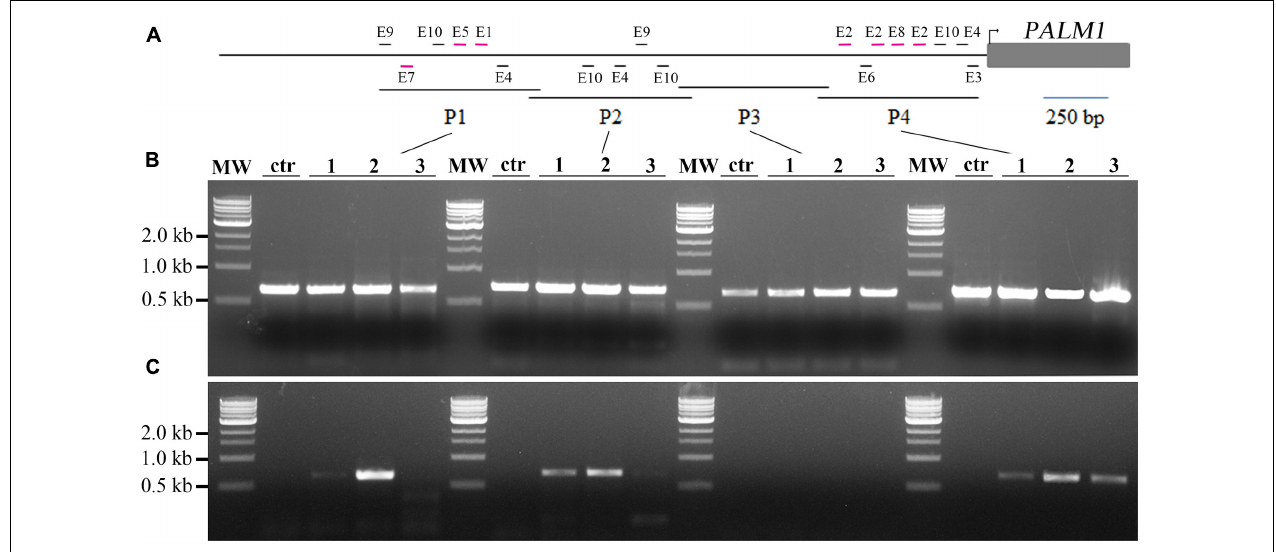
FIGURE 3 | Chromatin immunoprecipitation (ChIP)-PCR assays of interactions between MtARF3 and the PALM1 promoter in vivo . (A) A schematic drawing of the PALM1 promoter, showing location of putative auxin response elements (AuxREs; short horizontal lines) and the promoter fragments, P1–P4. (B) PCR analysis shows equal inputs of the DNA samples. (C) ChIP-PCR analysis shows enrichment of the PALM1 promoter fragments, P1, P2 and P4, but not P3, in FLAG-MtARF3-bound chromatins. Lanes MW, 1 kb marker from NEB; ctr, negative control in which wild type plants were used; and 1–3, three independent 35S:: FLAG - MtARF3 m plants. P1, P2, and P4 each contain several putative AuxREs (short horizontal lines), whereas P3 does not contain any AuxREs. P1 and P4 contain several putative AuxREs (short horizontal lines in purple) that exhibited significant inhibitory effects on luciferase reporter gene expression in the presence